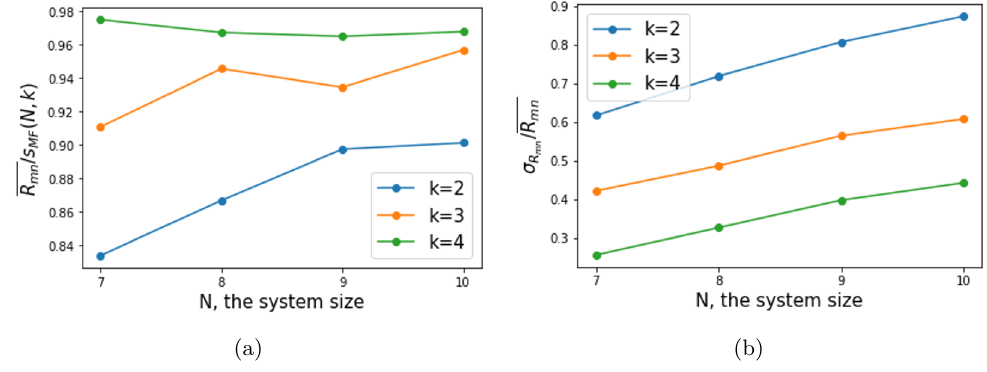
Figure 25 . Comparison of the average and standard deviation of the R mn matrix in the maximally chaotic regime with varying sizes.